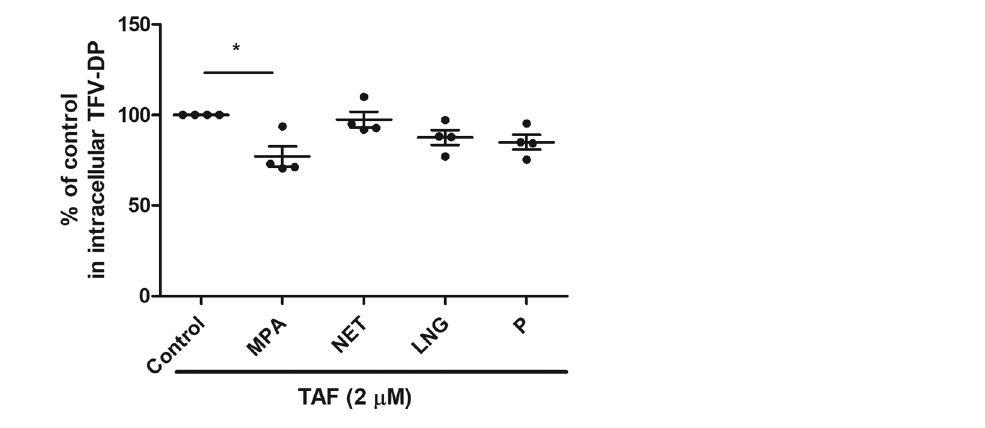
Figure 6. Lack of effect of NET, LNG and progesterone on intracellular TFV-DP concentrations in endometrial CD4 + T cells. TFV-DP concentrations were measured by LC-MS/MS in purified CD4 + T cells isolated from endometrium (n = 4) pre-treated with MPA, NET, LNG and progesterone (P) at 1 × 10 − 7 M for 24hr following treated with TAF (2 µ M) for 24hr. Data were normalized to % fold change from control values. (Each horizontal line represents the mean and SEM from 4